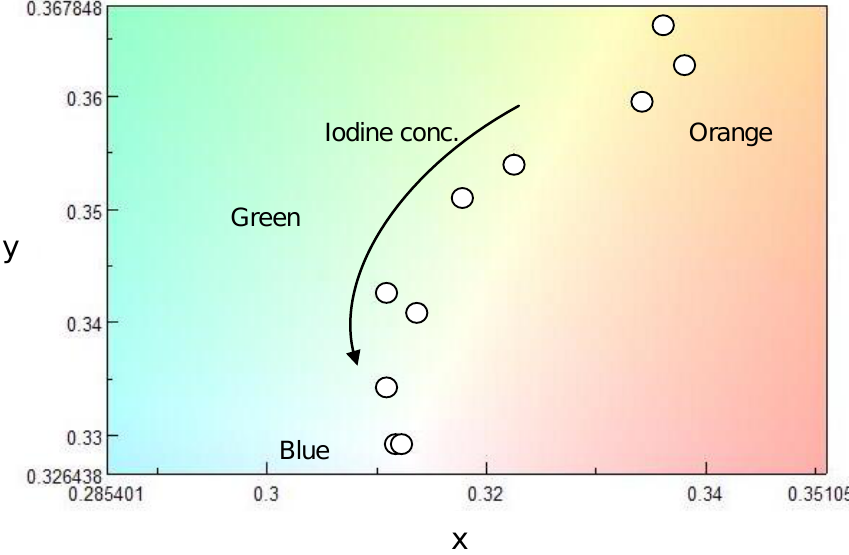
Figure 6. Change in CIE color space coordination diagram of ME1 with iodine